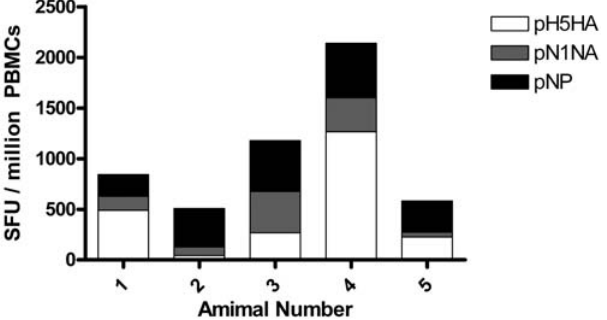
Figure 6. Induction of antigen-specific immune responses in rhesus macaques. Purified PBMCs were analyzed two weeks following the second immunization for antigen-specific interferon- c responses. Values from media-stimulated controls were subtracted from the corresponding antigen-stimulated monkey samples.